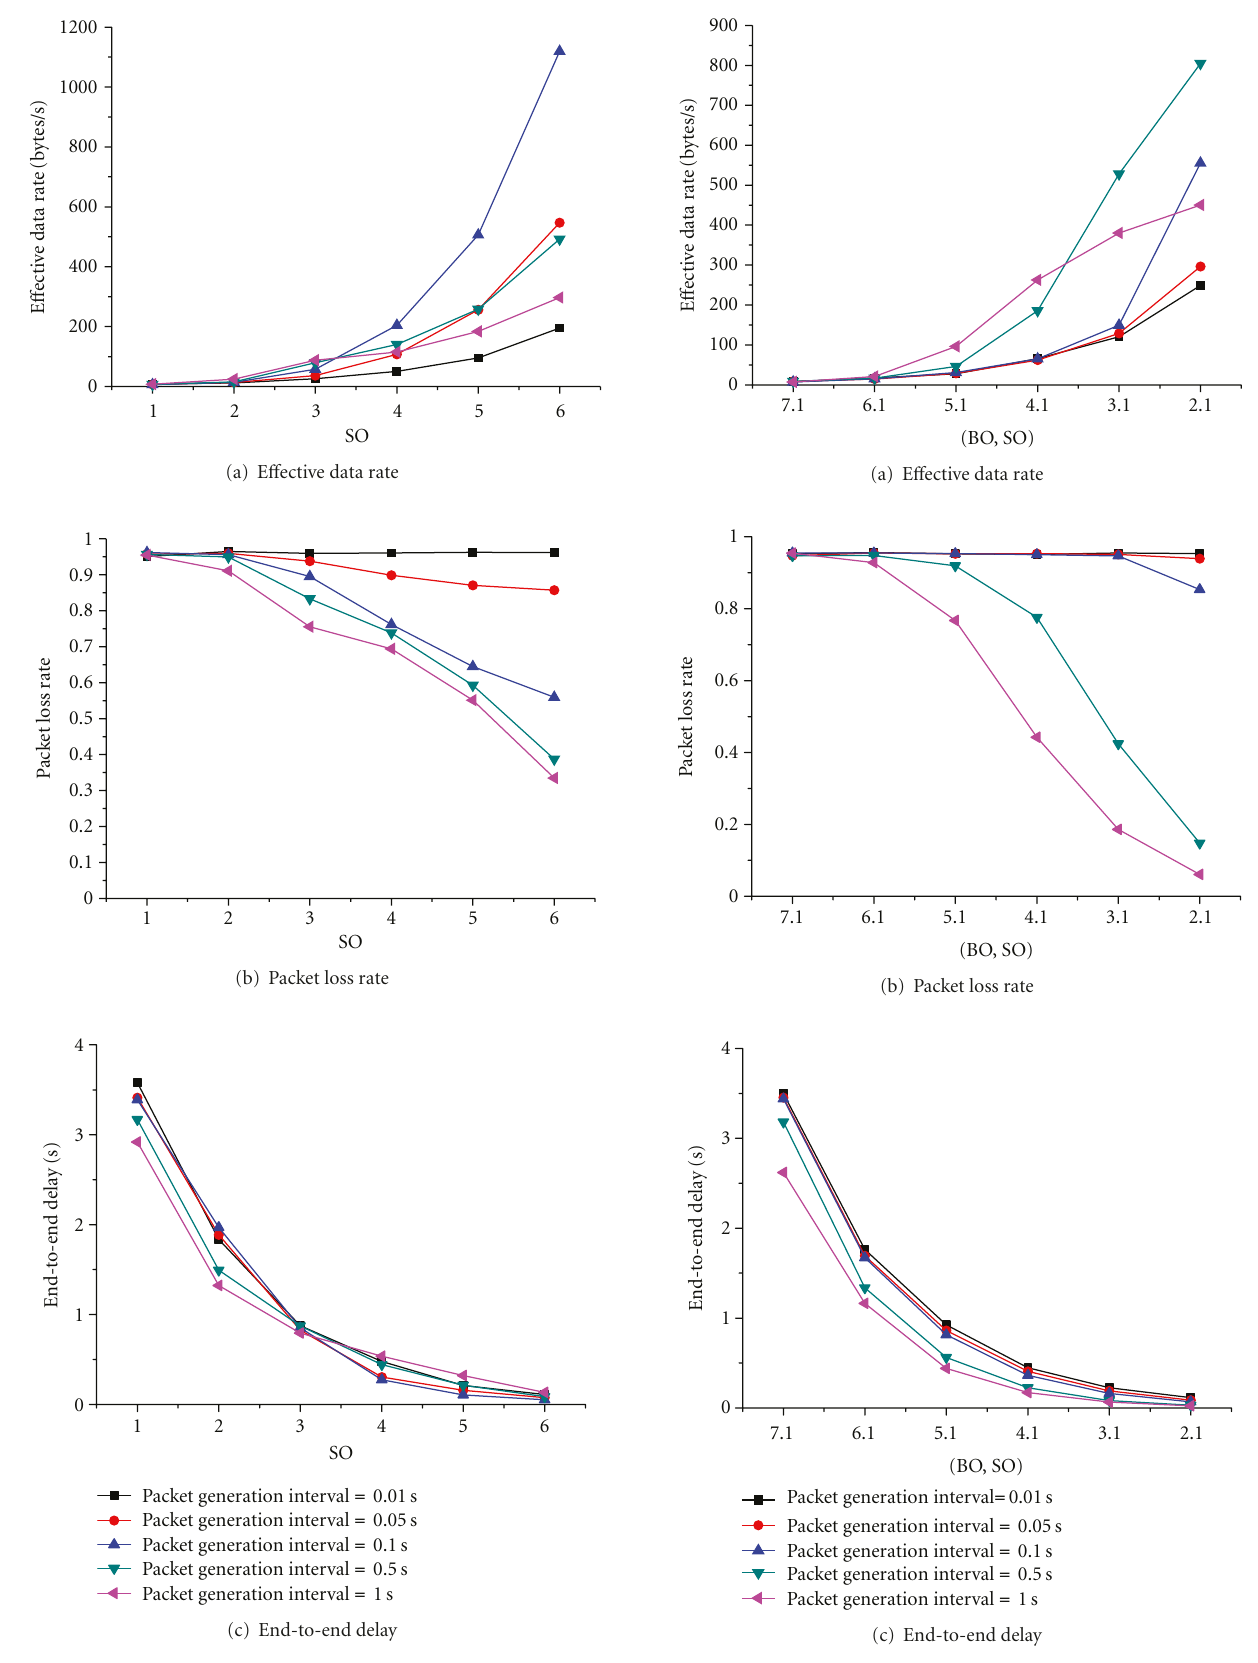
Figure 9: QoS with di ff erent SO values. Figure 10: QoS with di ff erent BO